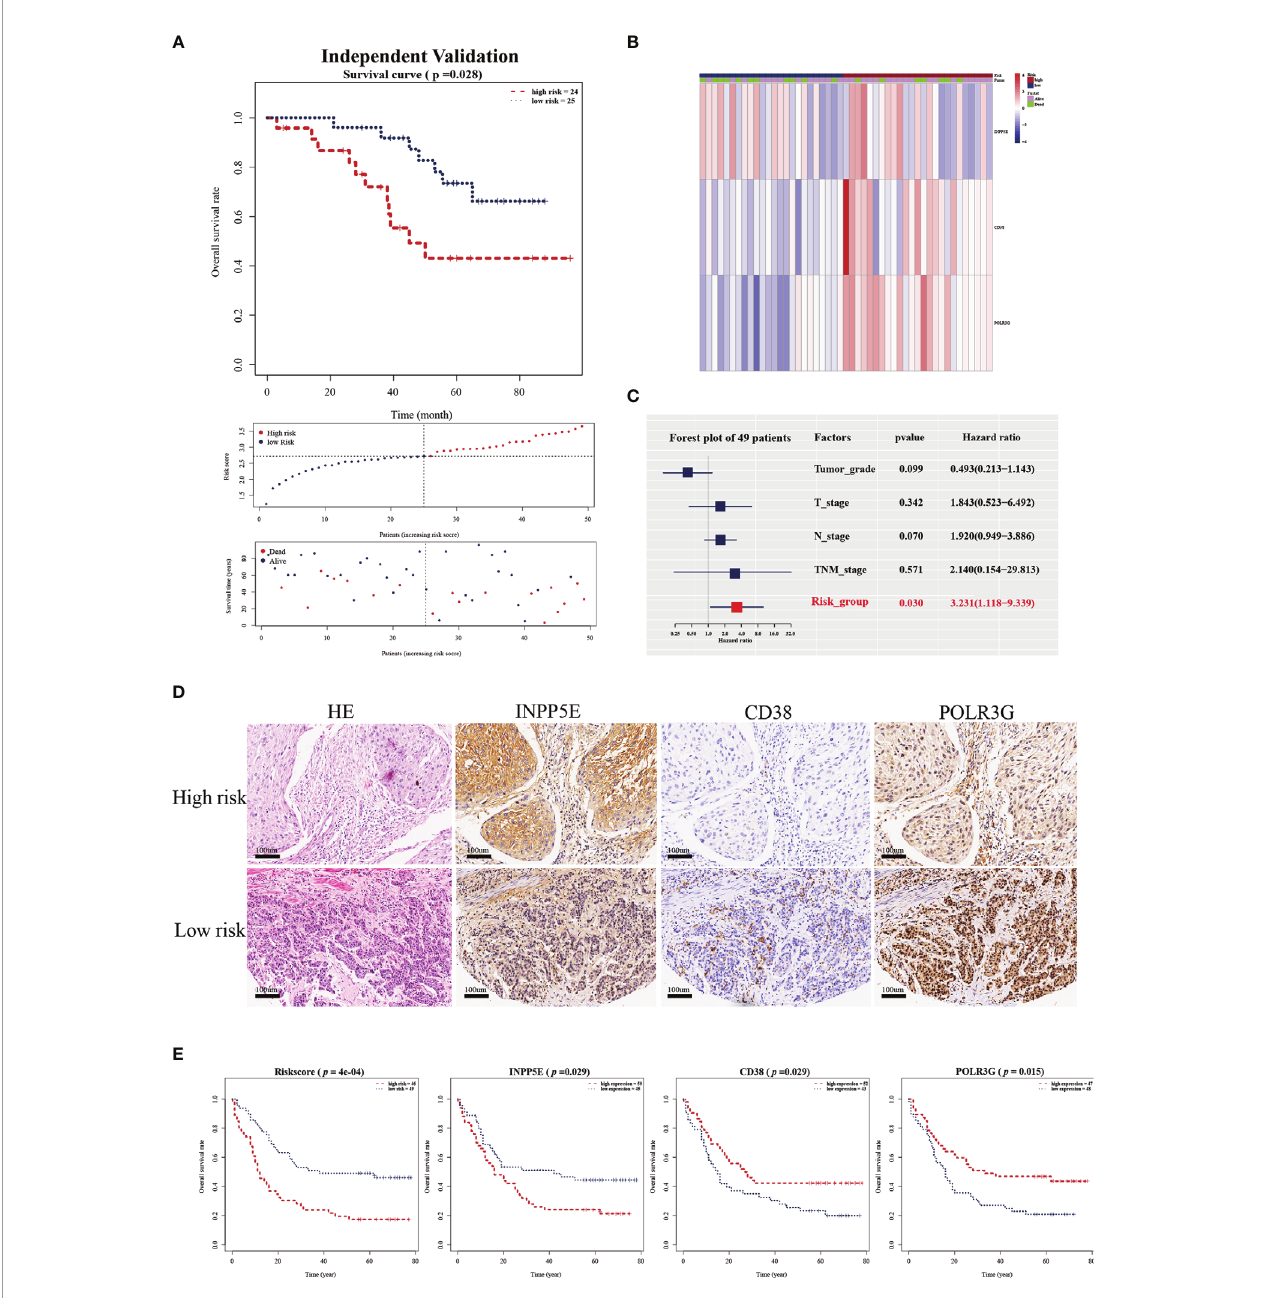
FIGURE 4 | Validation of the independent cohort by RT-qPCR and IHC analysis. (A) Kaplan-Meier survival analysis of overall survival, the distribution of patients ’ risk scores, and survival status for the high- and low-risk group in an independent validation cohort with 49 ESCC patients. (B) Heatmap of three gene signatures in an independent validation cohort with 49 ESCC patients. (C) The independent prognostic factor of the three gene signature by multivariate Cox regression analysis in an independent validation cohort with 49 ESCC patients. (D) HE staining and INPP5E, CD38 and POLR3G expression were analyzed by IHC analysis in an external validation cohort of 95 ESCC patients. (E) Kaplan-Meier survival analysis of overall survival for the risk score, INPP5E, CD38 and POLR3G in the IHC validation